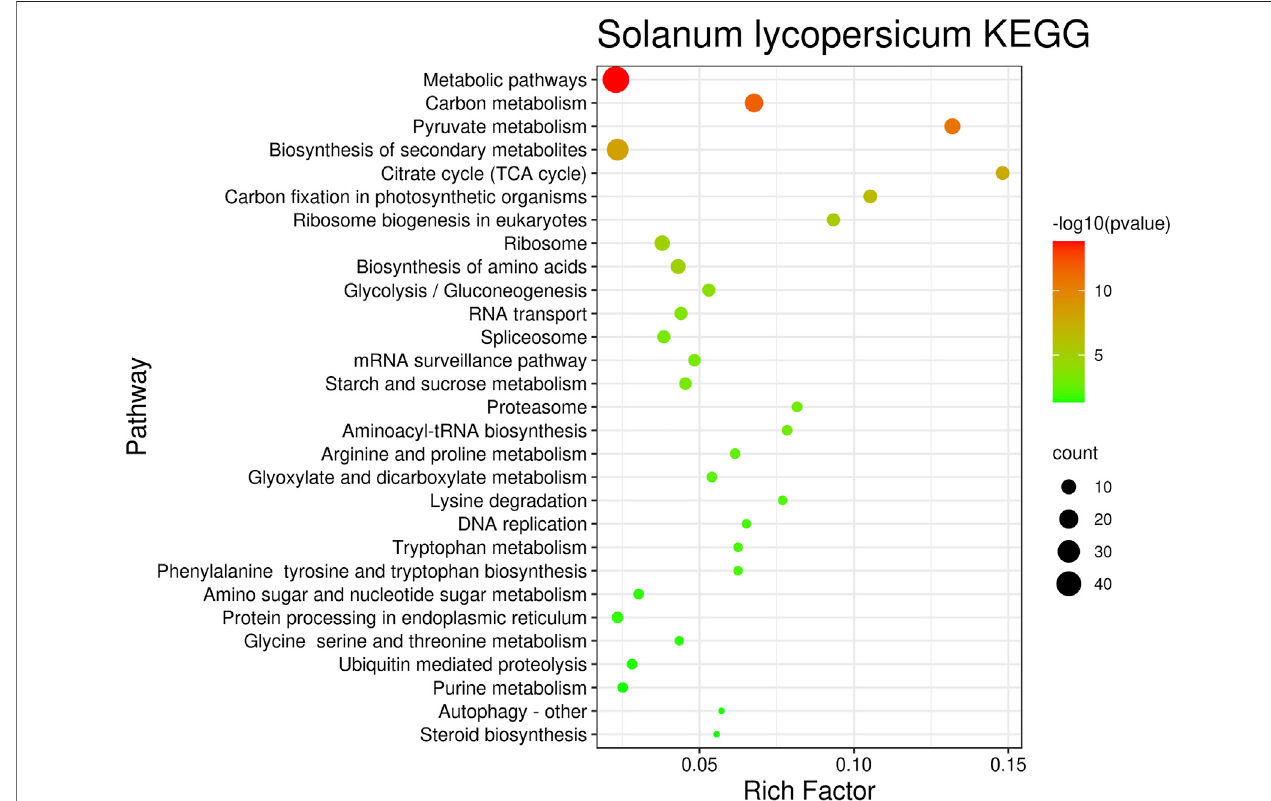
FIGURE 6 | Bubble diagram of Botrytis cinerea targeting Solanum lycopersicum ’ s KEGG_Pathway.